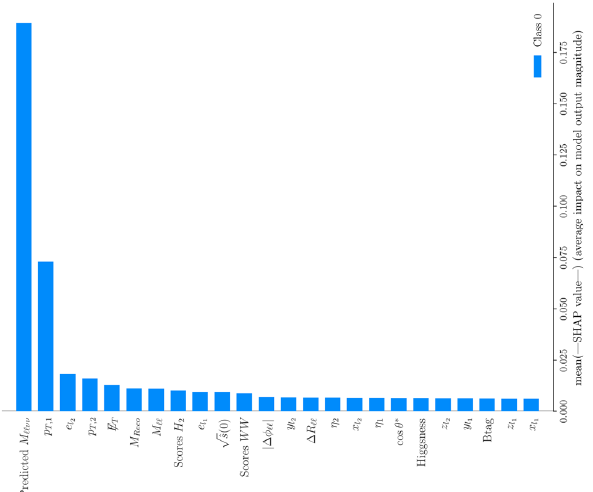
Fig. 13 The feature importance plot. Predicted M (cid:2)(cid:2)νν becomes the most important feature for classification when it is included in the data